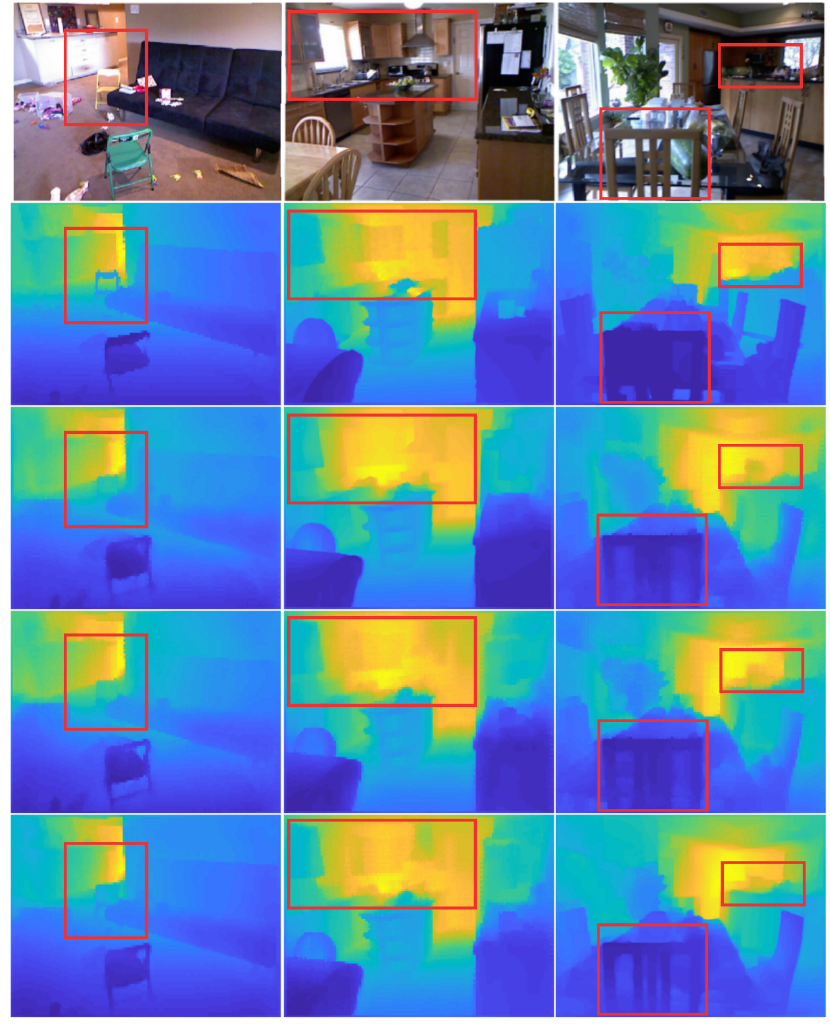
Figure 5. Examples from the test NYU Depth-v2 dataset of depth estimates with baseline, baseline with skip connection and our model. For each image, we show (row 1) the input image, (row 2) the ground-truth, (row 3) the output for the baseline model, (row 4) the output for the baseline with skip connection, and (row 5) the final estimate depth image with our